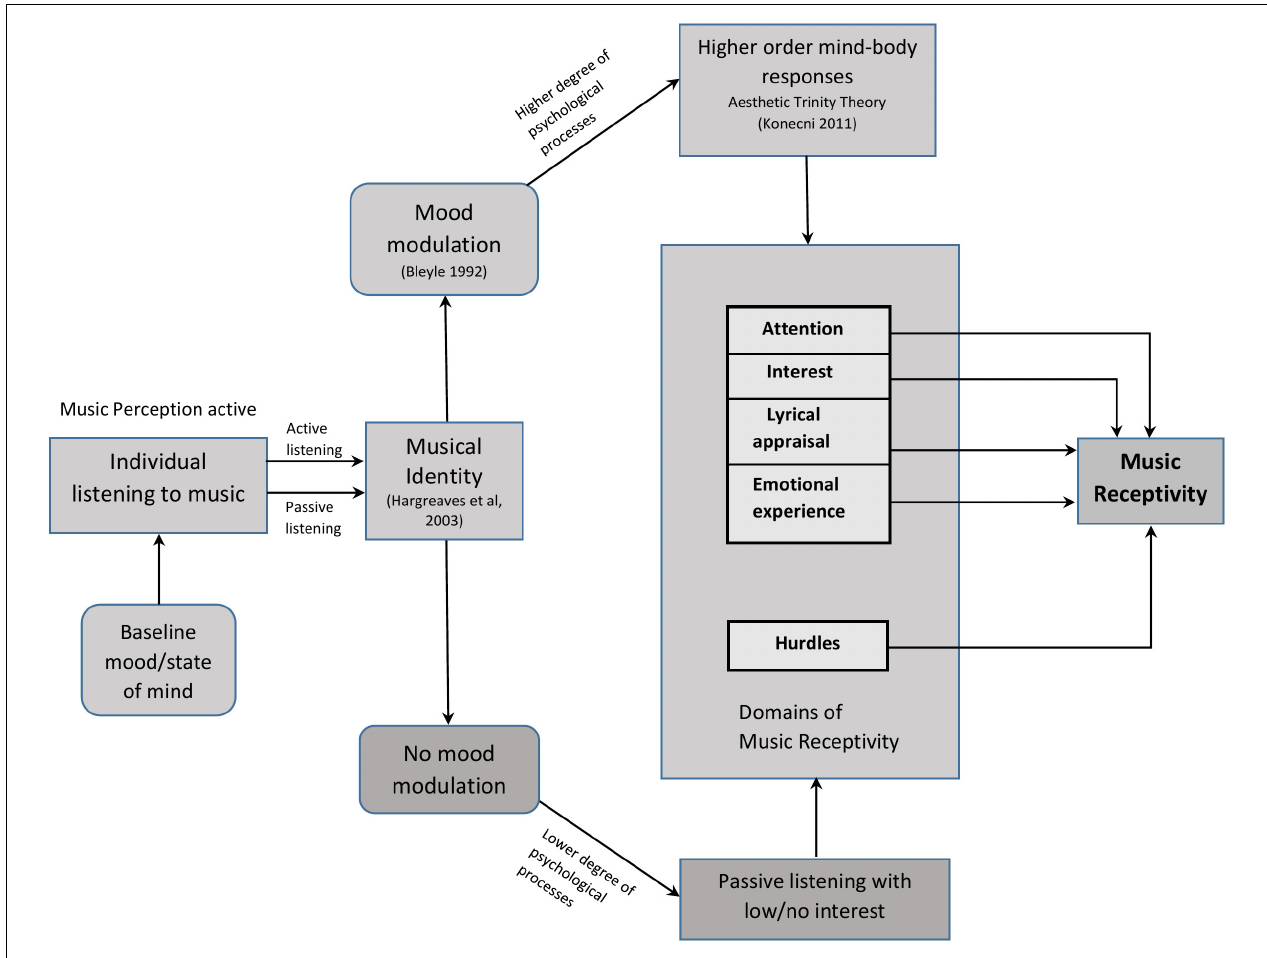
FIGURE 1 | Conceptual framework of music